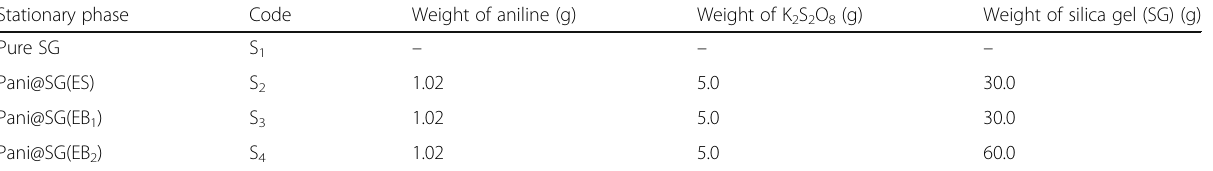
Table 2 Preparation details of Pani@SG nanocomposite-based stationary phases Stationary phase